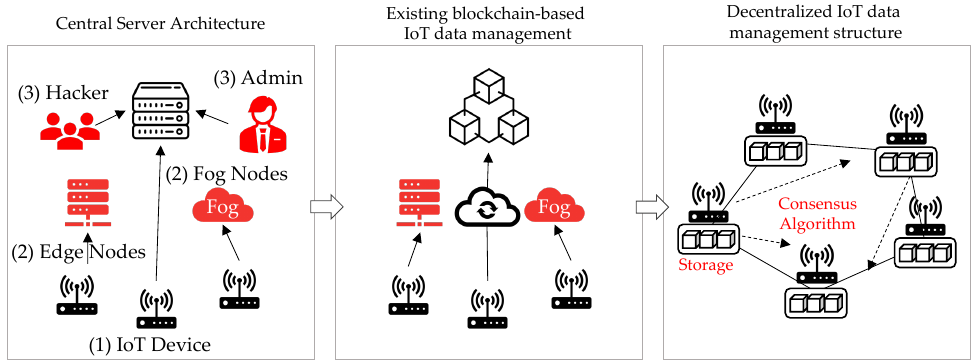
Figure 1. Comparison of IoT data management methods according to architecture (red indicates